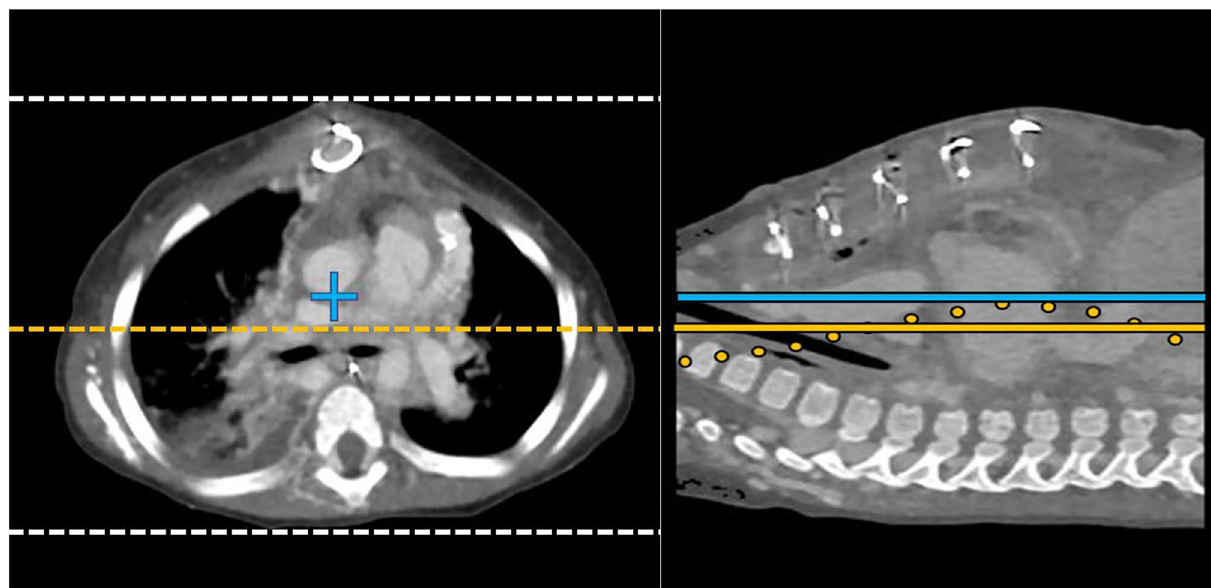
Figure 2. Definition of patient isocenter. ( a ) Axial image binarized with the CT value threshold to extract the patient isocenter, defined as the middle point (yellow dotted line) between the highest and lowest point (white dotted lines) of the extracted skin surface. All images were reconstructed so that the center of the image coincides with the isocenter of the gantry (blue cross). ( b ) Sagittal image showing the grand truth vertical center of patients, calculated using the averaged center values of each image along the scan length (yellow line). The patient was positioned below the isocenter of the gantry (blue